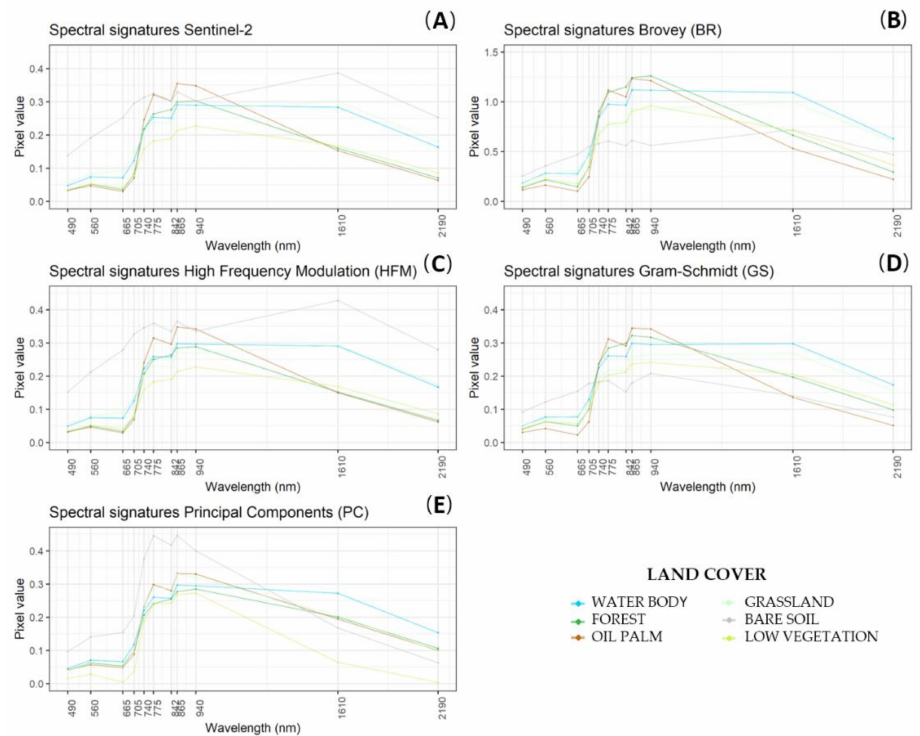
Figure 5. Spectral signatures of coverages identified on the Sentinel-2 optical image ( A ) and the images fused by the Brovey (BR) ( B ), high-frequency modulation (HFM) ( C ), Gram–Schmidt (GS) ( D ), and principal components (PC) ( E )